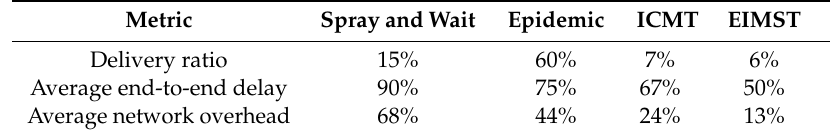
Table 3. The average improvement percentage of MSNN as compared to other four algorithms.